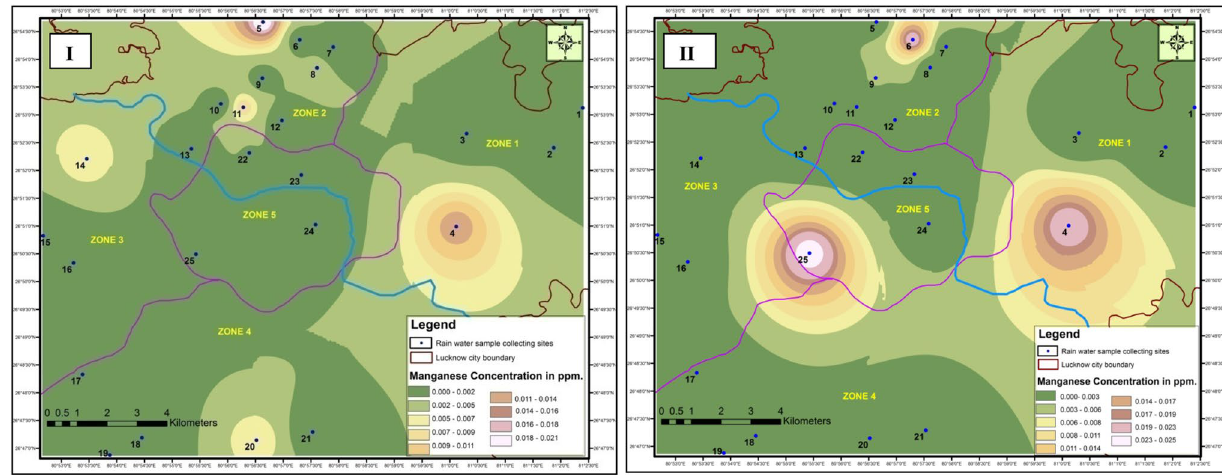
Fig. 9 Contour Map of manganese values at five zones of Lucknow city during first (I) and second (II)